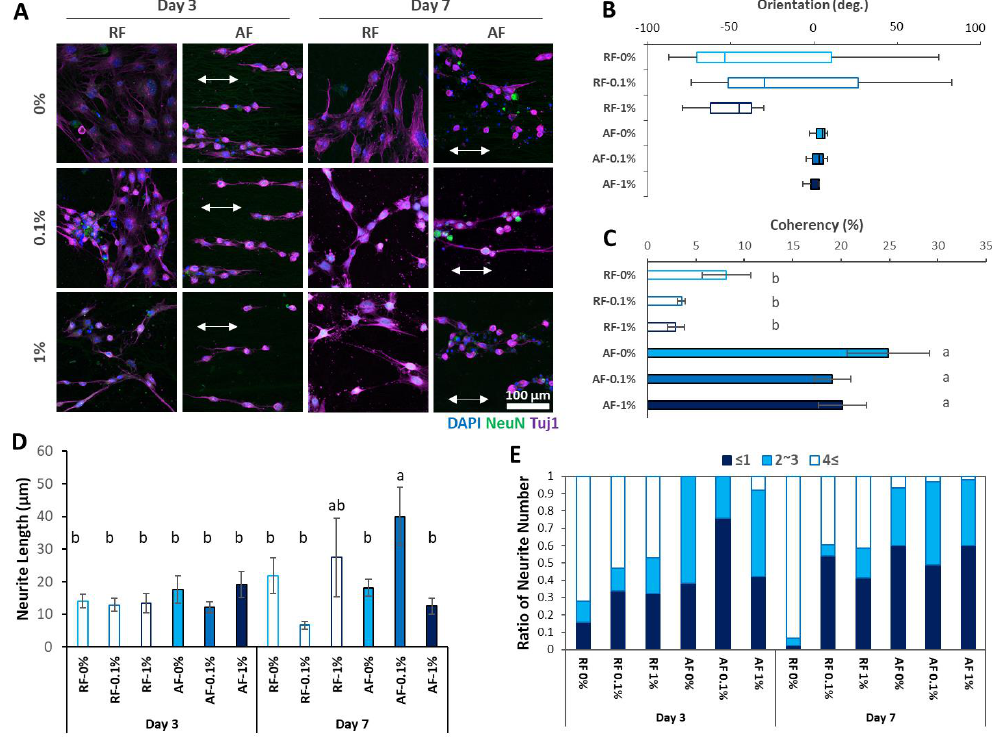
Figure 3. Neurogenic differentiation of DPSCs using RGO-PCL NFs. ( A ) ICC results. The RGO- incorporated NFs resulted in faster morphological transformation and early expression of Tuj-1 and NeuN. The DPSCs on the RFs seemed randomly aligned, whereas those on the AFs seemed well- aligned. ( B ) Orientation of the alignments of the differentiated cells. Corresponding to the alignments